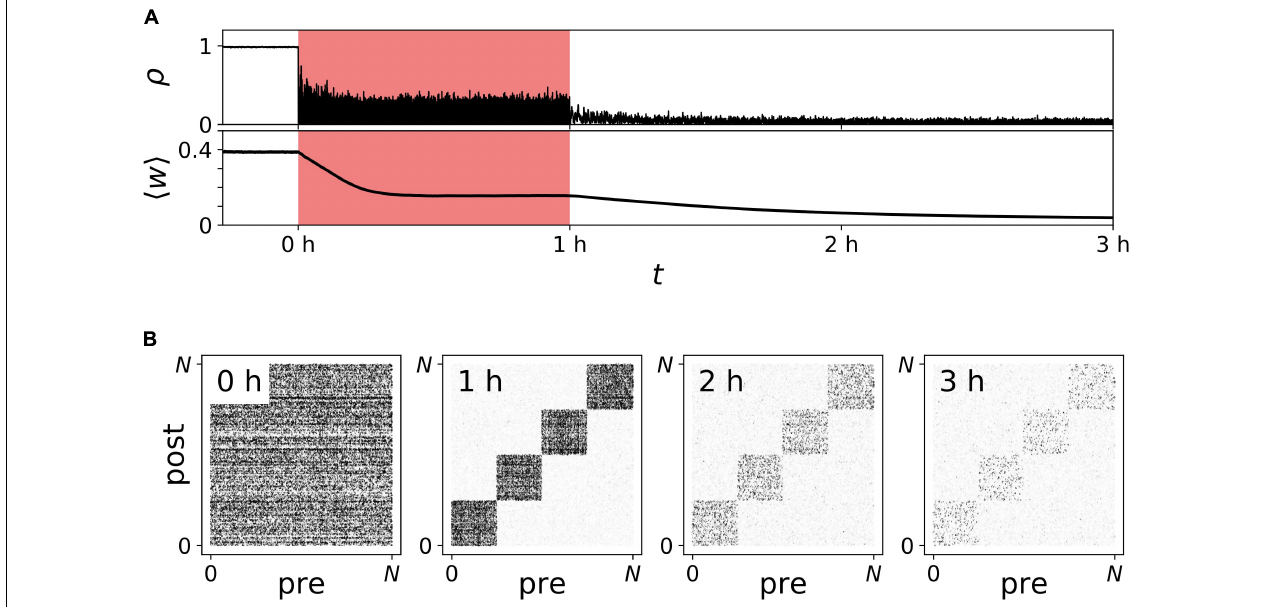
FIGURE 10 | Long-lasting desynchronization by sensory stimulation with noisy vibrotactile coordinated reset (vCR). (A) Time trace of the Kuramoto order parameter ρ ( t ) and the mean synaptic weight (cid:104) w (cid:105) ( t ) before, during (red), and after noisy vCR stimulation. (B) Snapshots of connectivity matrices containing the values of all synaptic weights w i → j ( t ) evaluated at indicated times after onset of stimulation; see also labels in panel (A) . Parameters: J = 23 . 5%, f CR = 1 . 5 Hz, and A = A 0